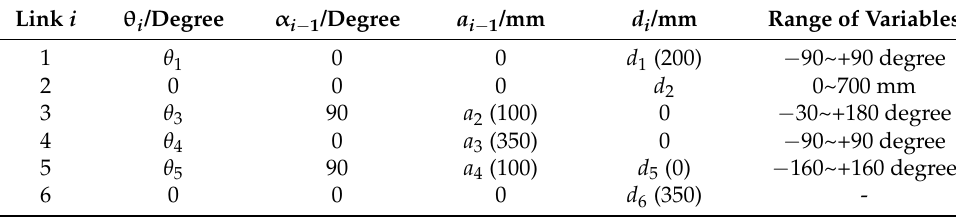
Figure 9. The coordinate system for the link of the jujube pruning manipulator. ( a ) The schematic diagram of the manipulator structure and ( b ) the coordinate system for the manipulator link. Note: θ 1 is the rotation angle of the base, degree; θ 3 is the rotation angle of the shoulder joint, degree; θ 4 is the rotation angle of the elbow joint, degree; θ 5 is the rotation angle of the forearm, degree; X 0 Y 0 Z 0 is the base coordinate system; X 1 Y 1 Z 1 is the coordinate system at the top of the base; X 2 Y 2 Z 2 is the coordinate system for the mobile joint of the machine body; X 3 Y 3 Z 3 is the coordinate system of the shoulder joint; X 4 Y 4 Z 4 is the coordinate system of the elbow joint; X 5 Y 5 Z 5 is the coordinate system for the rotary joint of the forearm; and noa is the coordinate system of the end-effector. Table 2. The parameters for the link of the jujube pruning